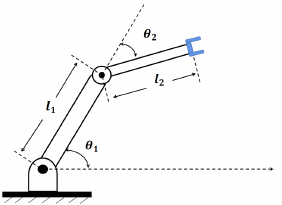
Figure 3. The model of the 2-DOF manipulator.